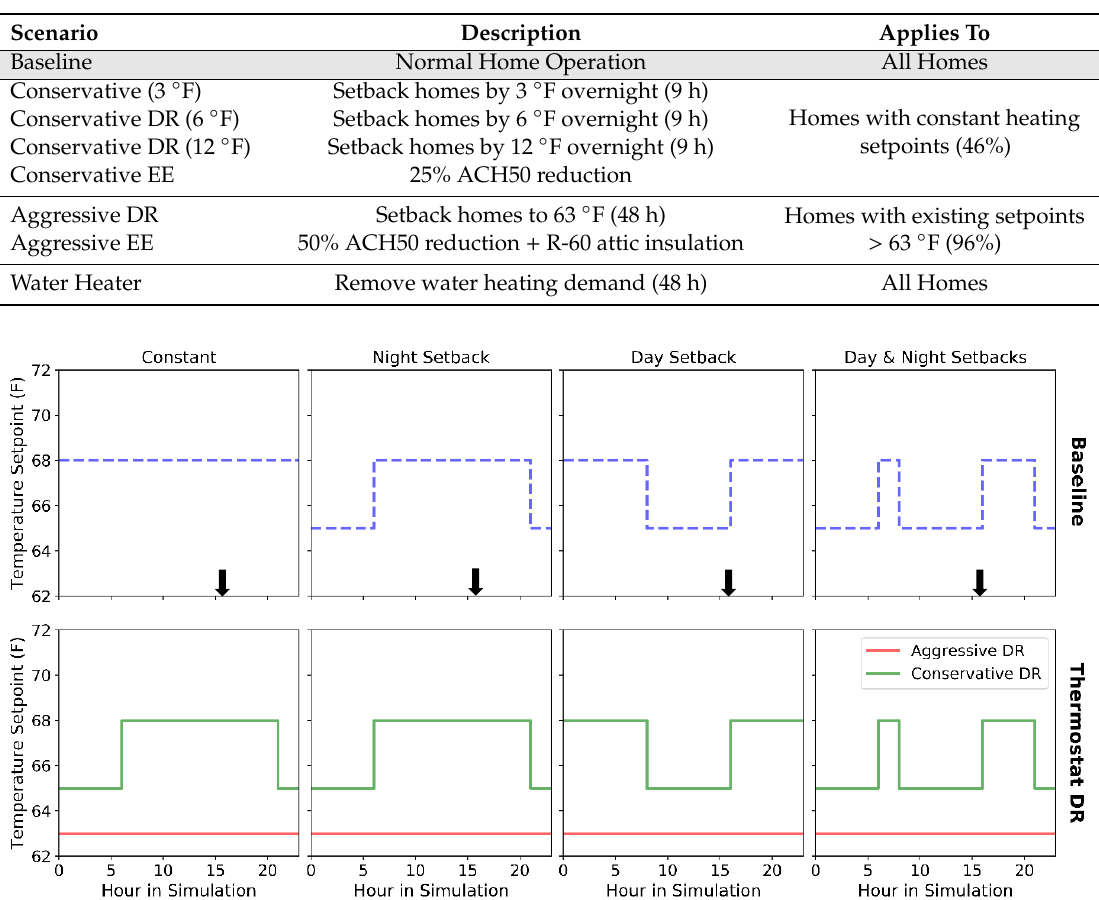
Table 1. Summary of demand response (DR) and energy efficiency (EE) scenarios.